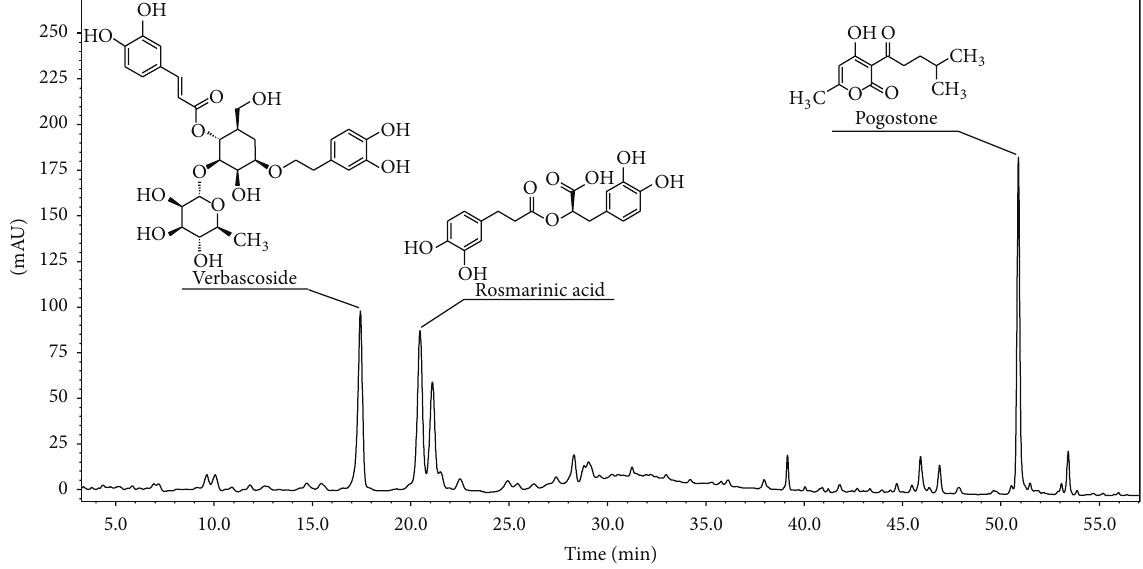
Figure 1: HPLC chromatographs of ERP with detector responses at